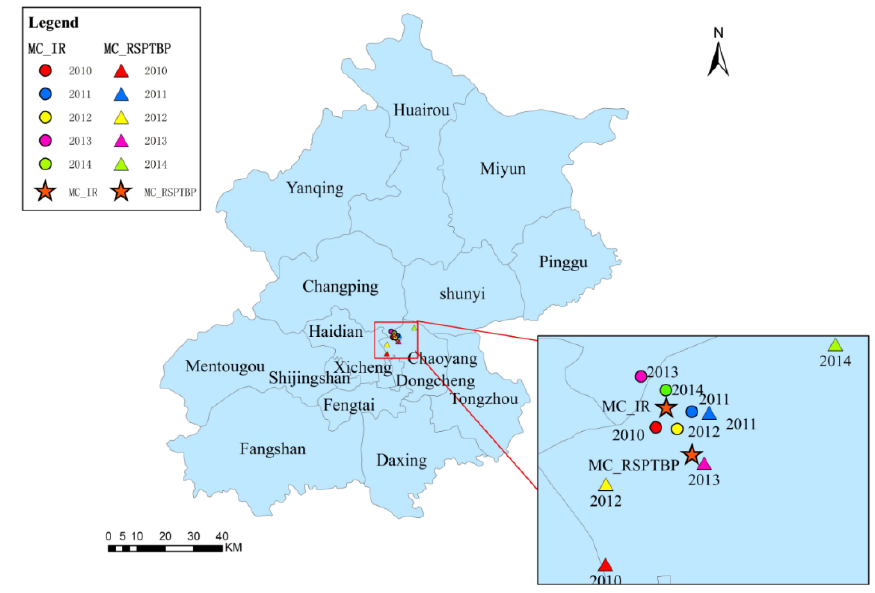
Figure 10. The distributions of IR and RSPTBP MC in Beijing from 2010 to 2014.